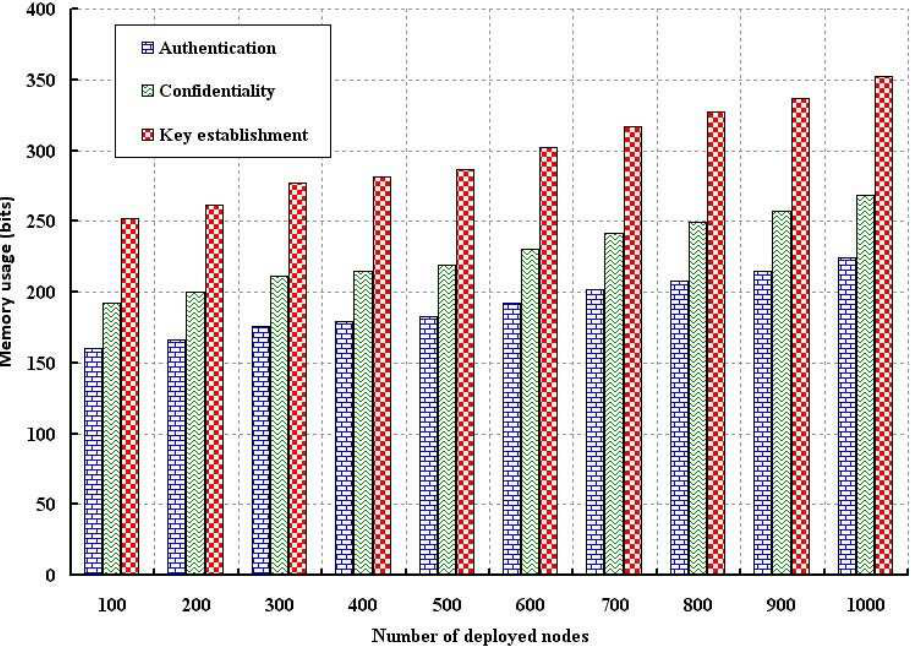
Figure 11. Evaluation of memory usage with different number of nodes.